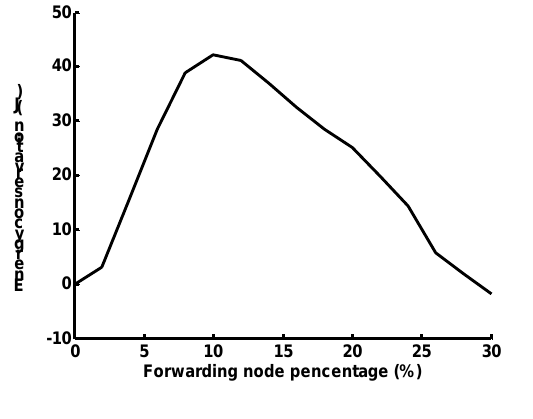
Figure 9. Affect of forwarding node percentage on energy conservation of DGASA optimization